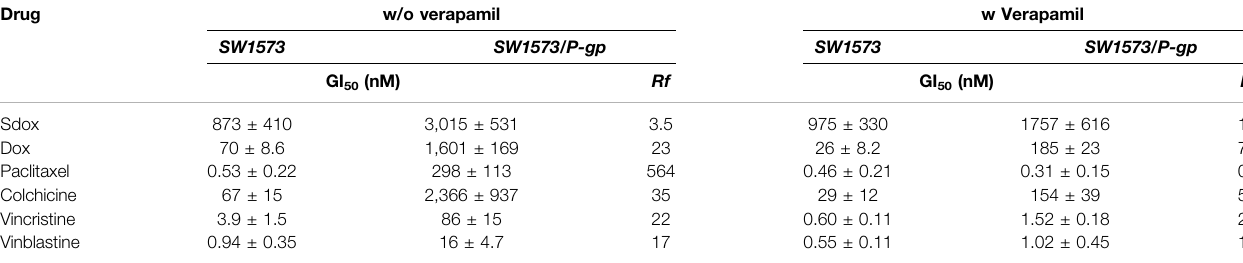
TABLE 7 | Antiproliferative activity (GI 50 ) of Sdox, Dox, and tubulin-interacting drugs in SW1573 and SW1573/P-gp cell lines. Drug